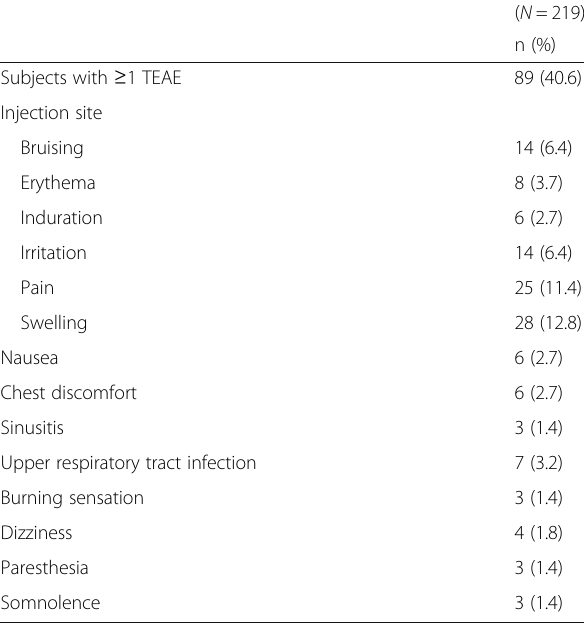
Table 2 Treatment-emergent adverse events occurring in ≥ 1% of subjects treated with